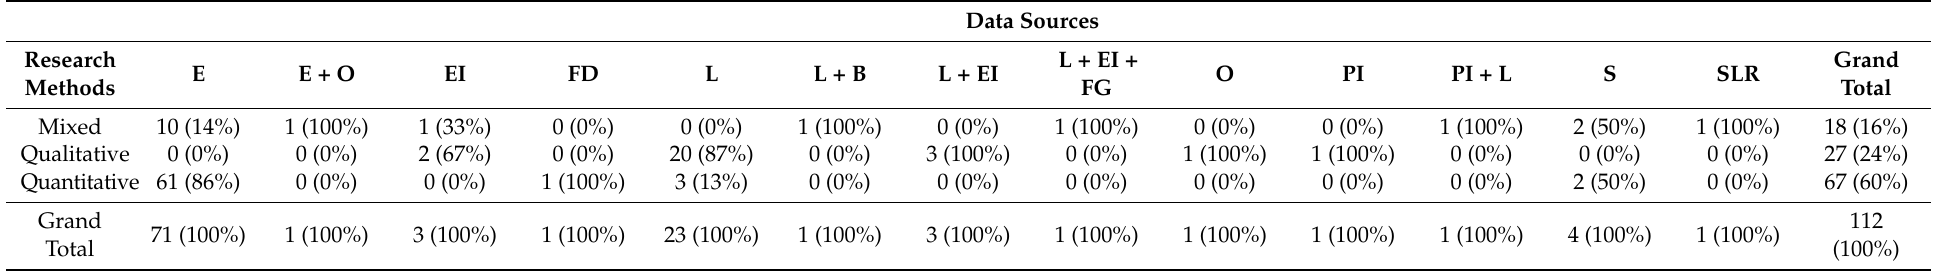
Table 5. Crosstabulation between the type of research methods and the types of data sources employed in employed in Construction Robotics and Human–robot teams